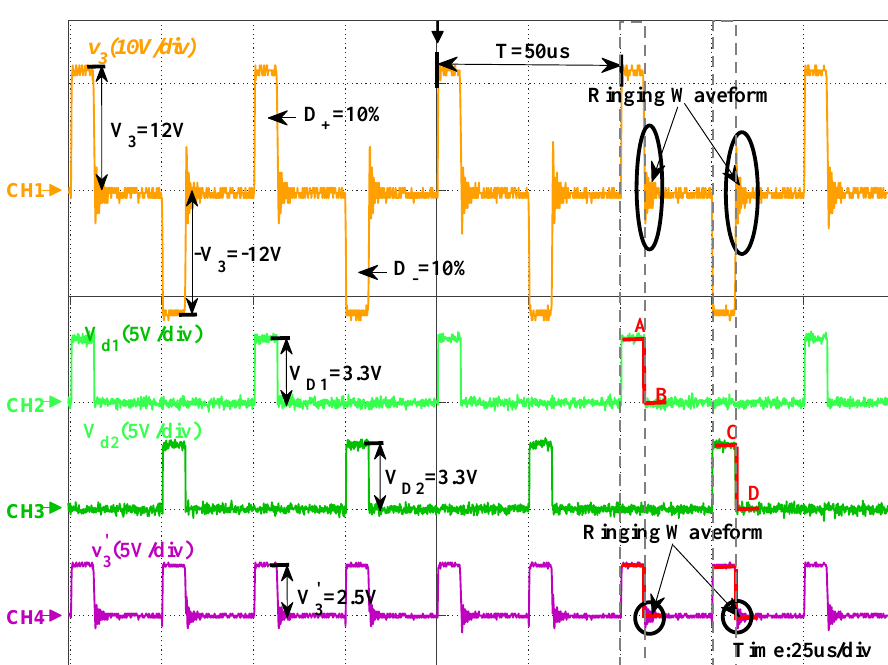
Figure 9. The key waveforms of the Signal Pre-processing Circuit.